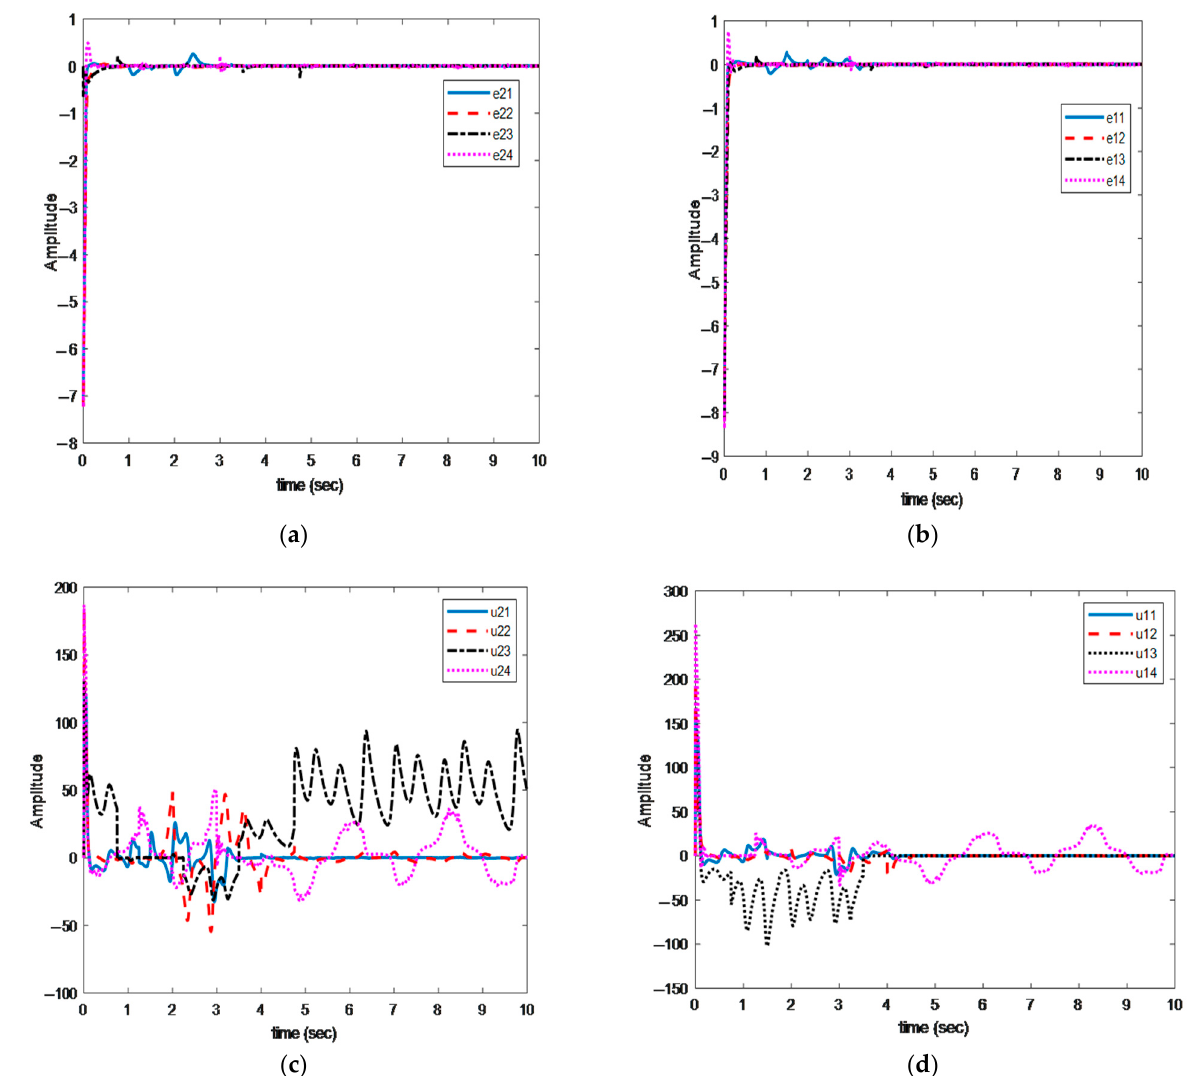
Figure 6. Curves of synchronization errors obtained during disturbance and uncertainty. (subfigures ( a , b ) show dynamic state errors and subfigures ( c , d ) show control efforts). Figure 5 shows that the parameters and time delay errors in the multi-mode synchronization properly converge to zero despite the uncertainty and disturbance. The figure shows minimal fluctuation. Therefore, the synchronization approach produced successful results despite the parametric changes. Figure 5 depicts the multi-mode synchronization errors during disturbance and structural uncertainty. Figure 6 presents the error values for the disturbance and uncertainty boundaries estimation. As indicated in Figure 6,despite the disturbance and uncertainty, the errors were large initially and then approached zero with very little fluctuation. There were fluctuations in these control efforts. Synchronization errors altered slightly with parameter variation, which rapidly converged to zero over time. Figure 7 indicates that the errors in estimating the uncertain boundaries were initially large due to the initial values of the parameters but are approximated to zero over time. Additionally, the errors related to the uncertainty have converged with very little oscillation to near-zero values. The proper and fast estimation of error boundaries as well as the rapid identification of system parameters leads to proper controller performance. Overall, despite the disturbances, uncertainties, and parametric changes in the master and slave hyper-chaotic systems, the multi-mode synchronization, with the help of the proposed adaptive controller, performed desirably and produced excellent